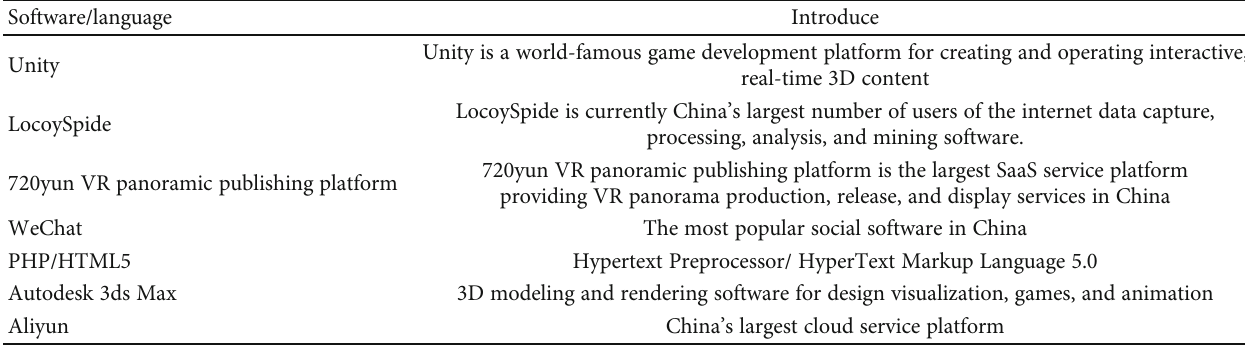
Table 1: The development software and technology of virtual